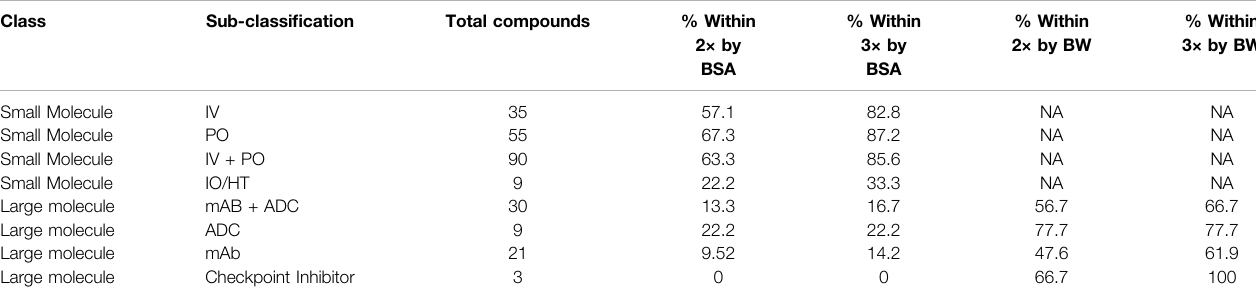
TABLE 1 | Prediction of clinical doses by BSA and BW based approaches for oncology